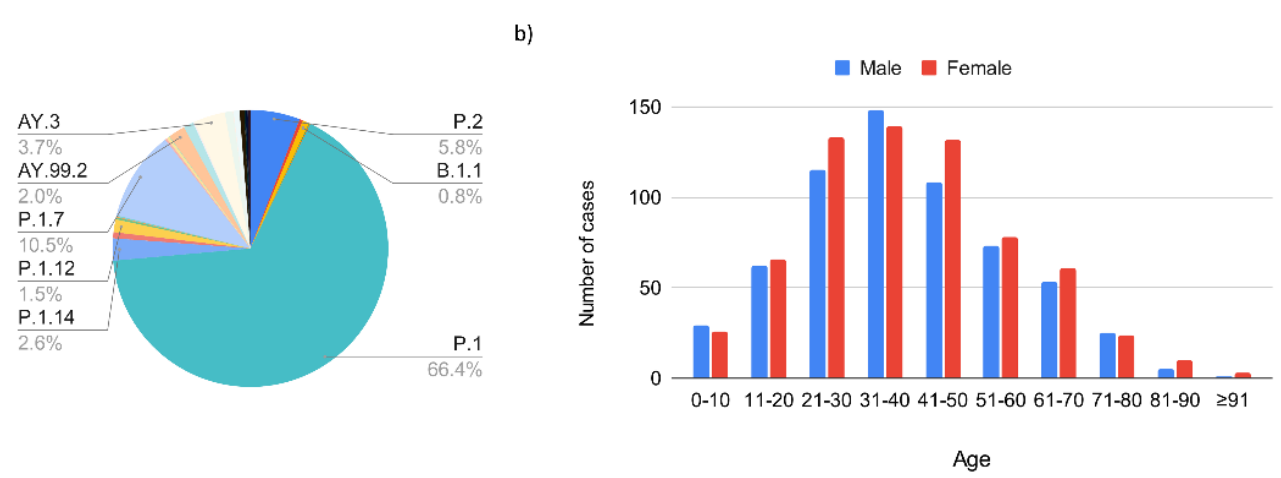
Figure 3. Surveillance of SARS-CoV-2 variants and clinical symptoms during the first wave. The data are distributed according to ( a ) variants of interest and concern during the first wave; ( b ) demographic characteristics of the positive patients divided by sex and age.